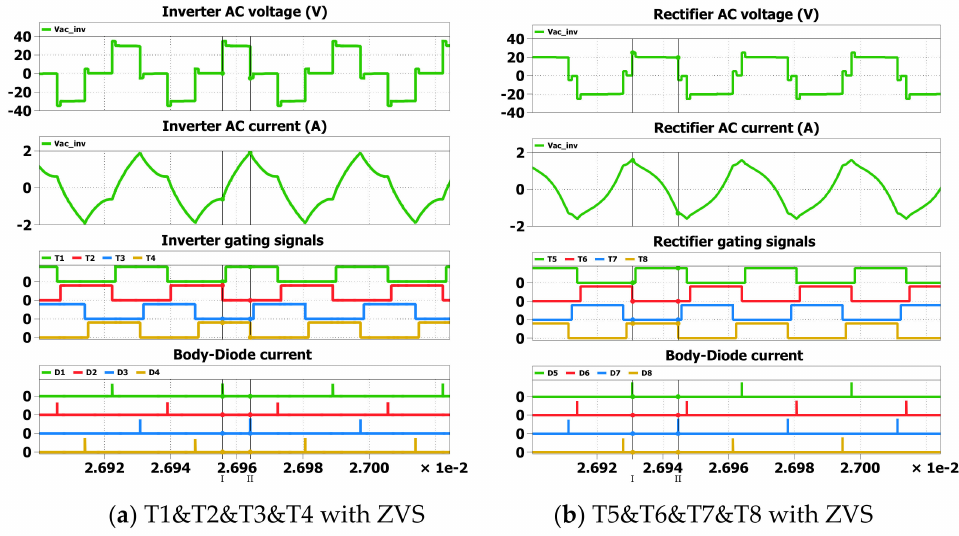
Figure 15. Inverter/rectifier voltage/current, MOSFET gating signals, diode currents PLECS circuit simulation results for Vo = 20 V, Io = 0.4 A (R dc = 50 Ω , emulate CC mode) with β p (deg) = 82.3 ◦ , β s (deg) = 151, δ (deg) = 90 ◦ .